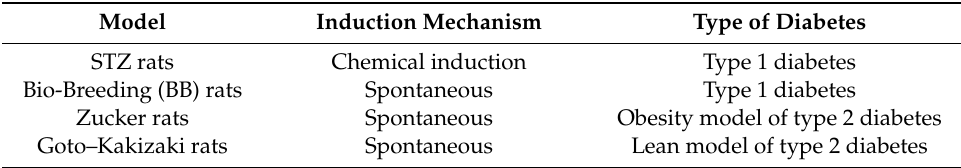
Table 1. Characteristics of the animal models of diabetes that appear in this review